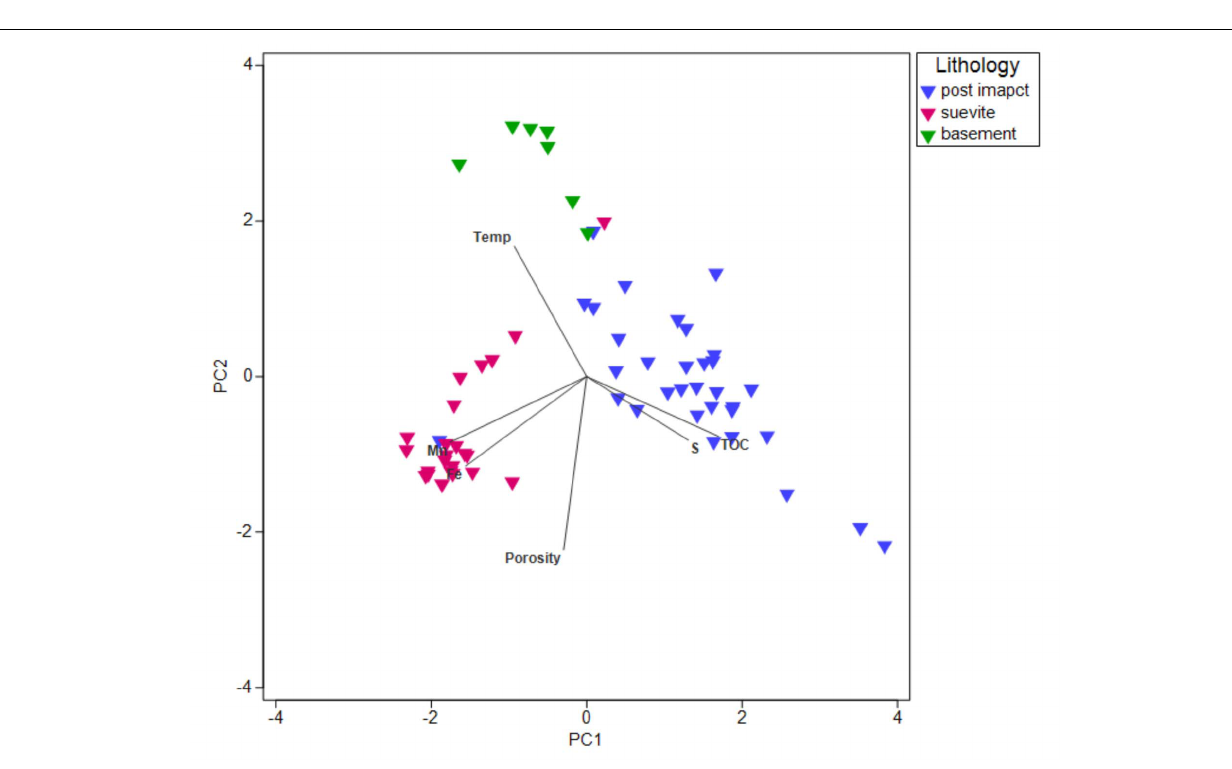
Frontiers in Microbiology |